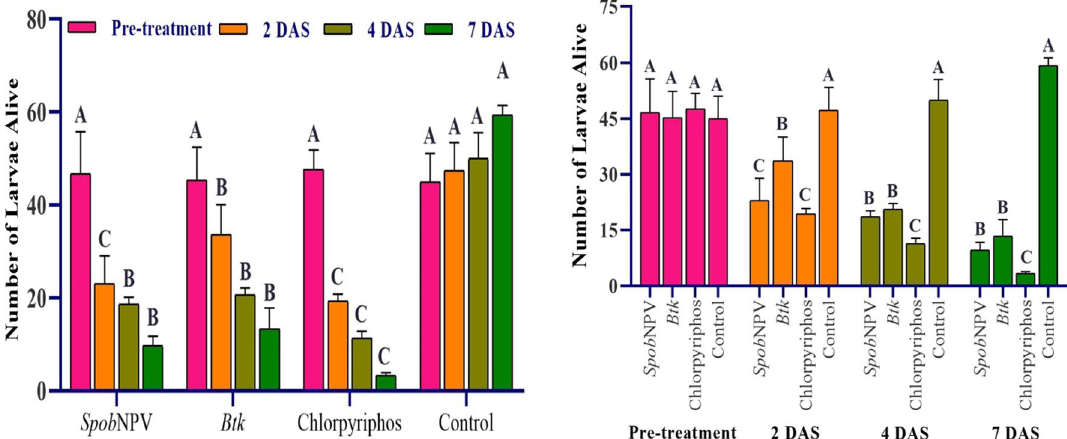
Fig. 5 Spilosoma obliqua third instar larvae survival at 2, 4 and 7 days after imposing of